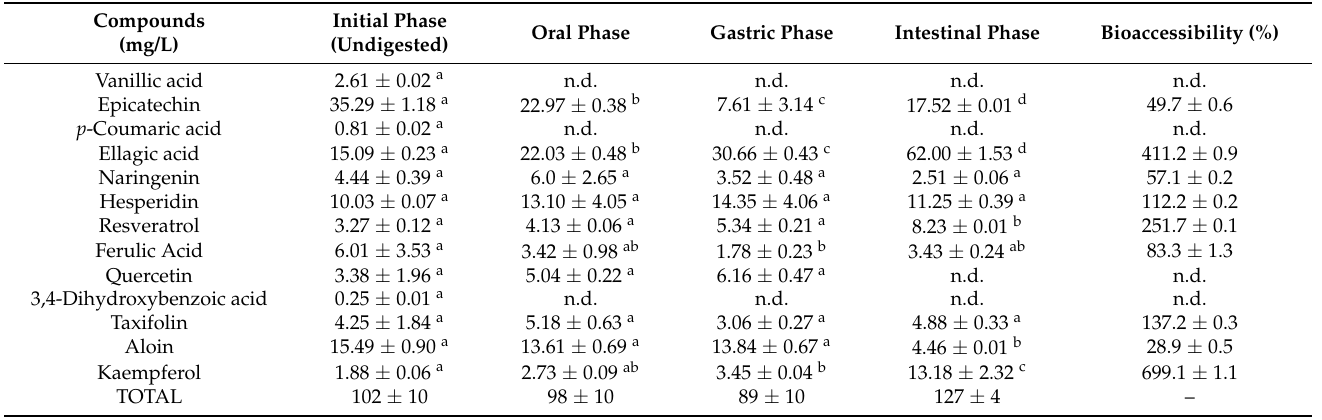
Table 3. Phenolic compound identification and quantification of undigested and in vitro digestion of Aloe vera juice fermentation with Enterococcus faecium ( AvF ). Data are given in